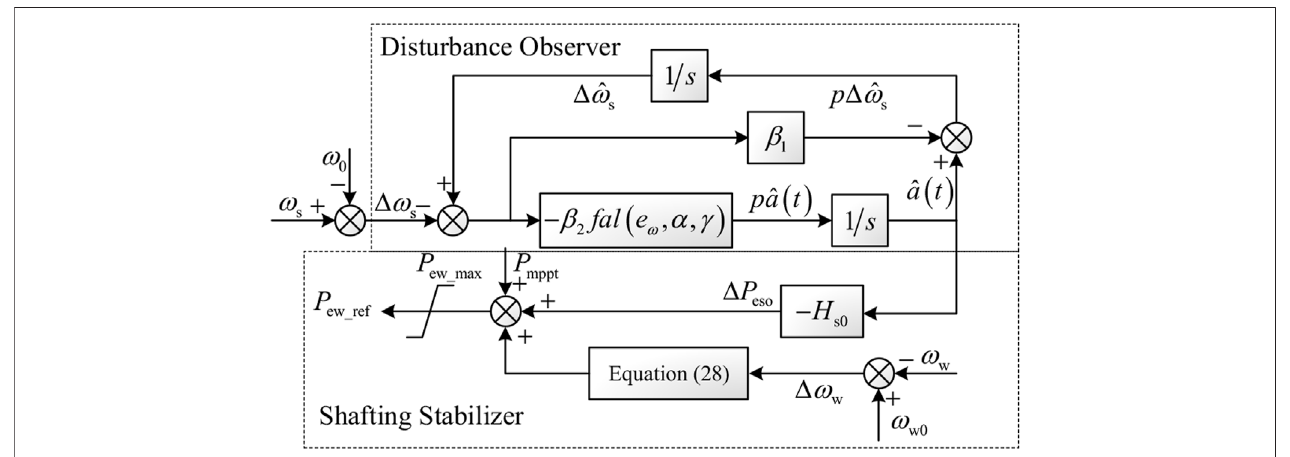
FIGURE 2 | Diagram of virtual inertia control based on extended disturbance observer.